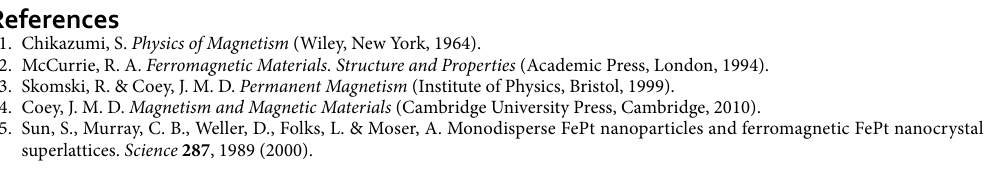
′′ -Fe 16 N 2 (813 K) 32